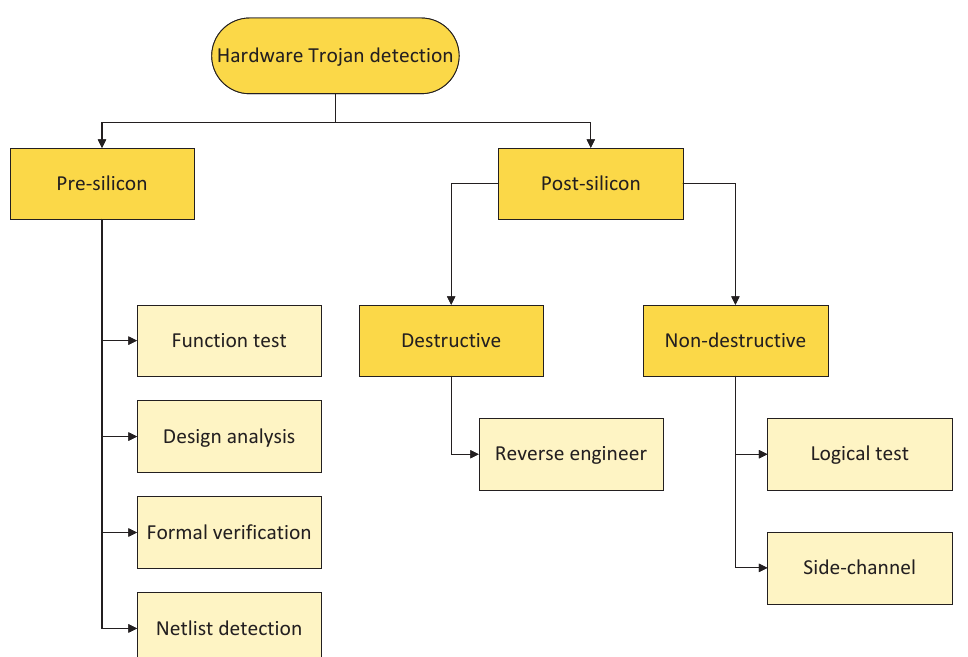
Figure 2. Hardware Trojan-detection